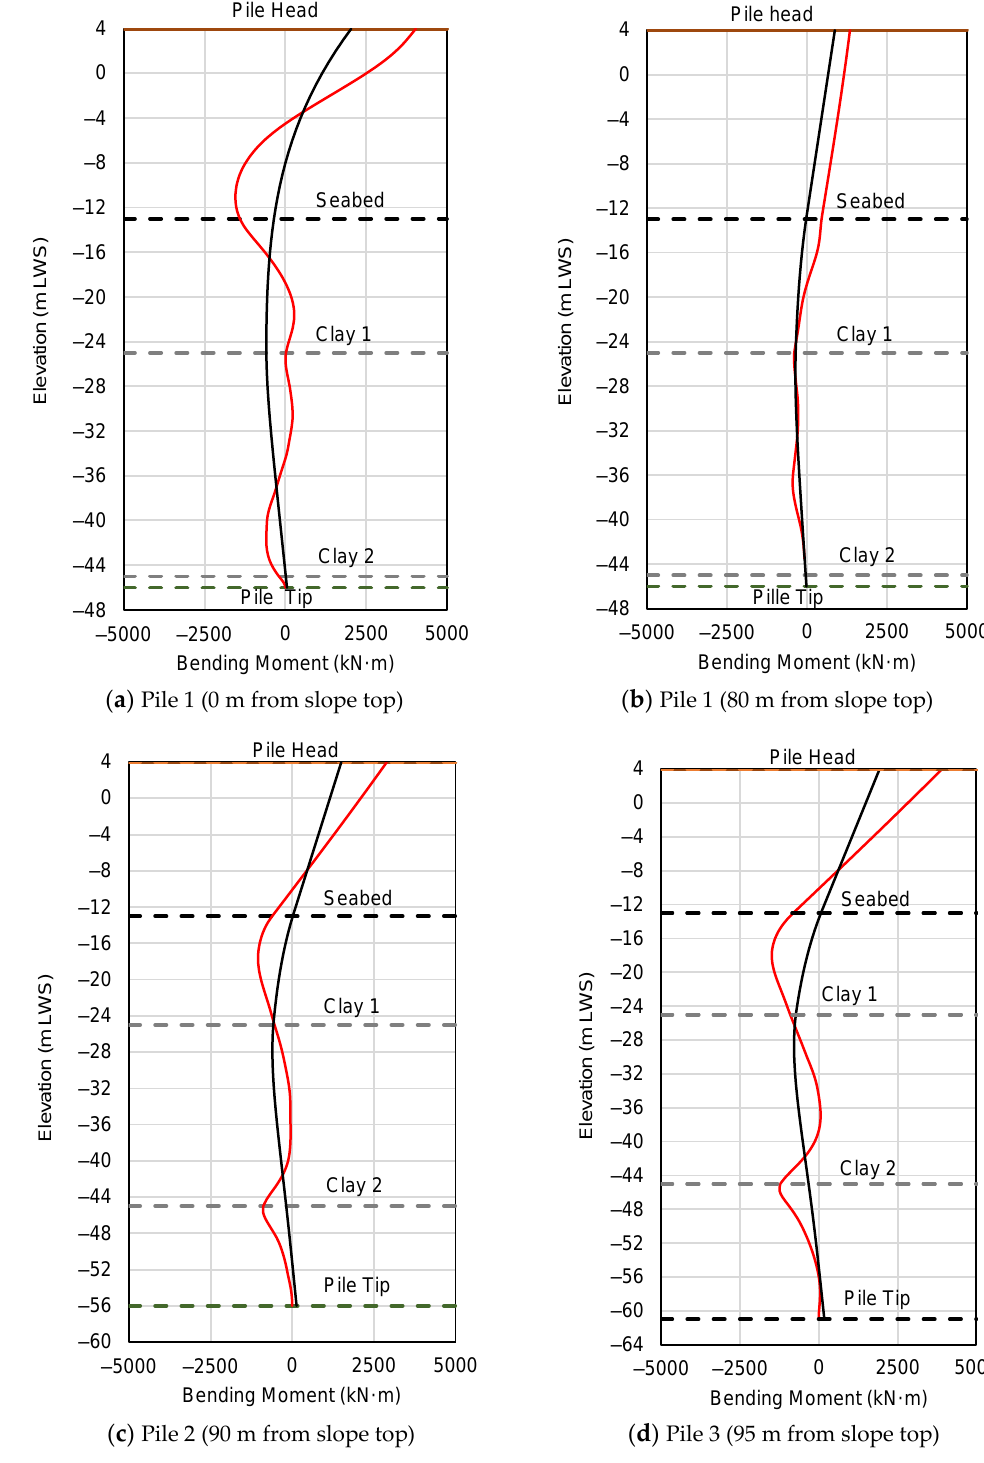
Figure 19. Bending moment distribution of the PSW considering the inertial forces due to the ME waveform (Scenario 2).